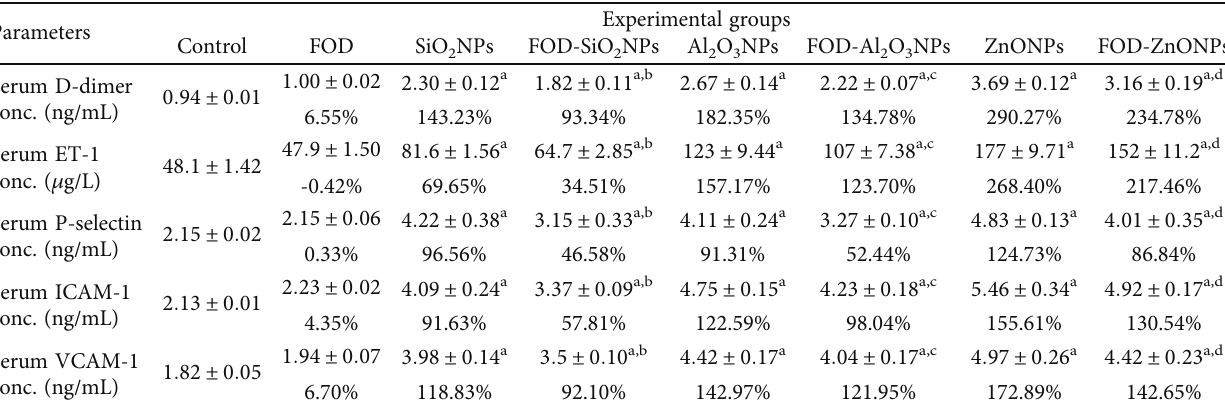
Table 2: The e ff ects of fi g with olive oil and date palm fruit extract on the blood coagulation and endothelial dysfunction markers of male rats treated with silicon oxide nanoparticles, aluminum oxide nanoparticles, or zinc oxide nanoparticles for 75 days. Parameters